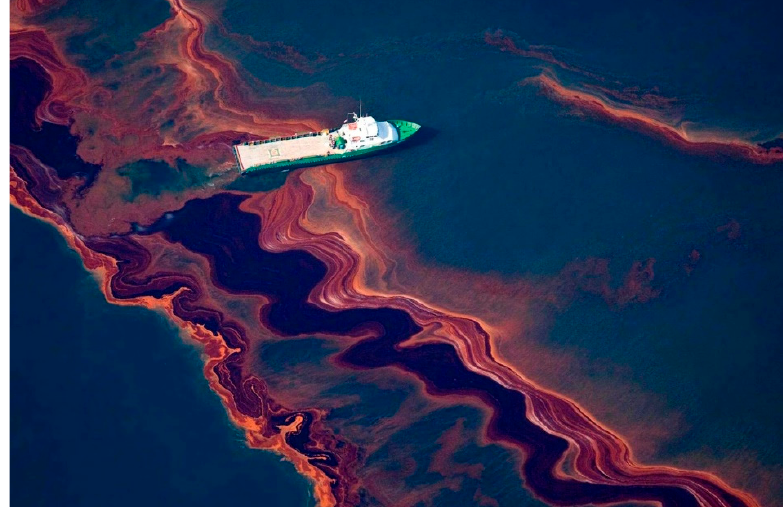
Figure 3. Example of an oil spill image obtained from a UAV [49].